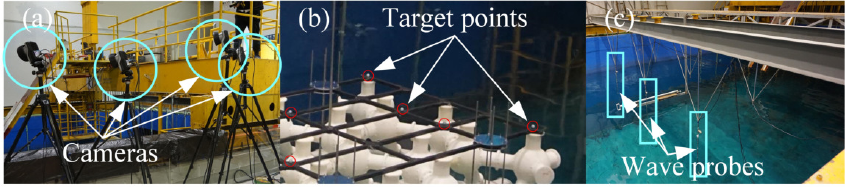
Figure 7. ( a ) motion capture cameras for non-contact measuring; ( b ) target points on the deck; ( c ) wave probes.